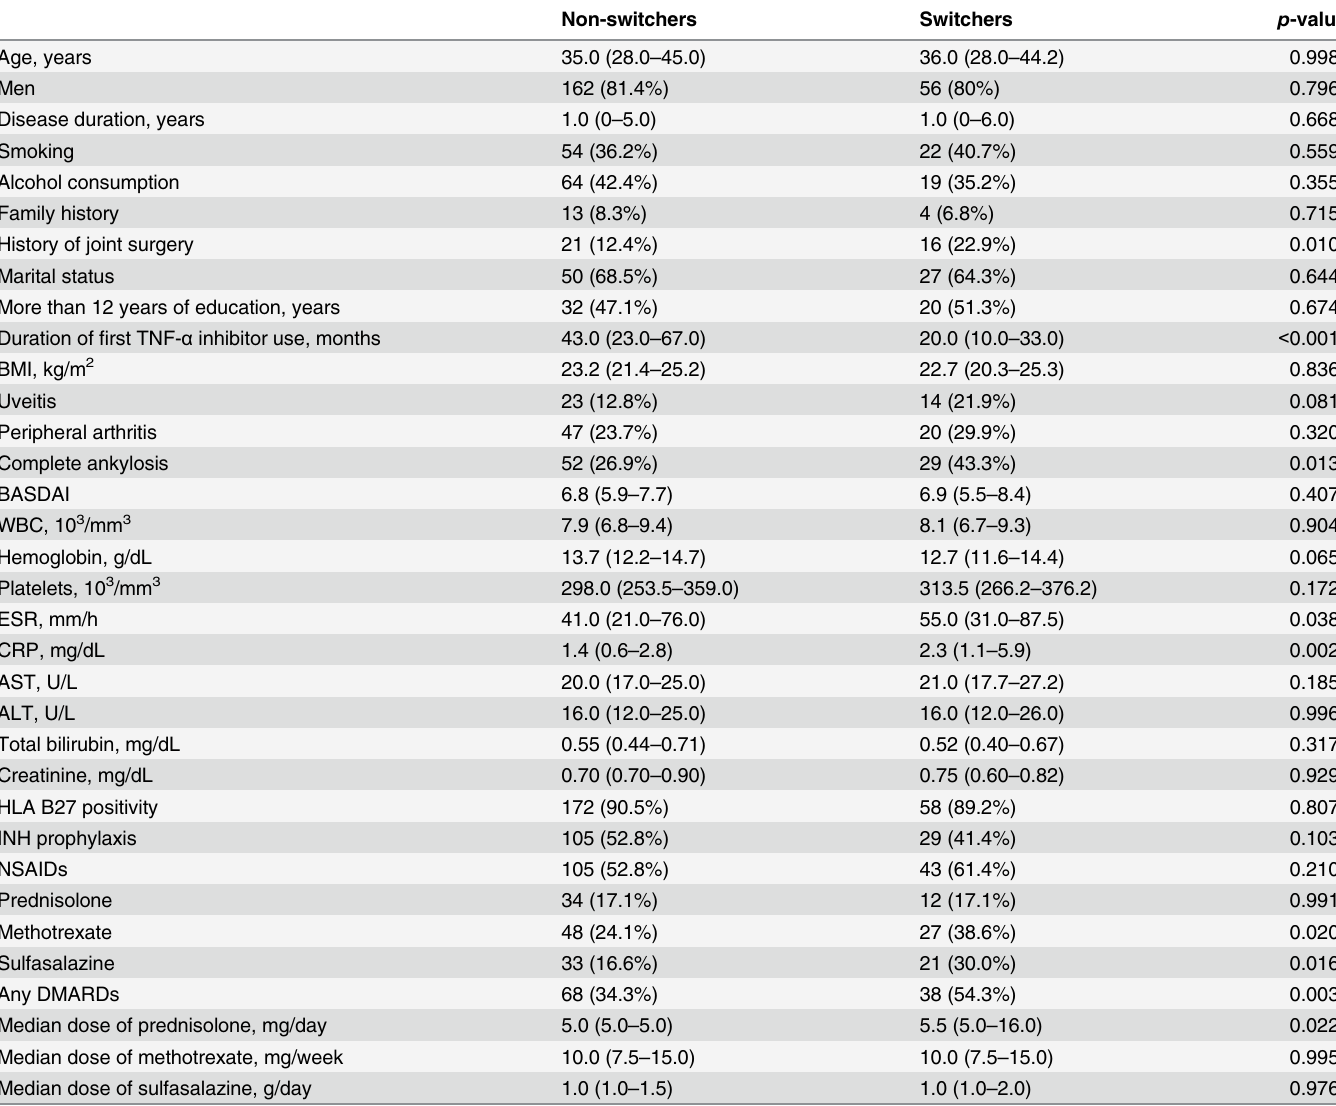
Table 2. Baseline characteristics and laboratory findings of patients starting their first TNF- α inhibitor according to whether they subsequently switched or